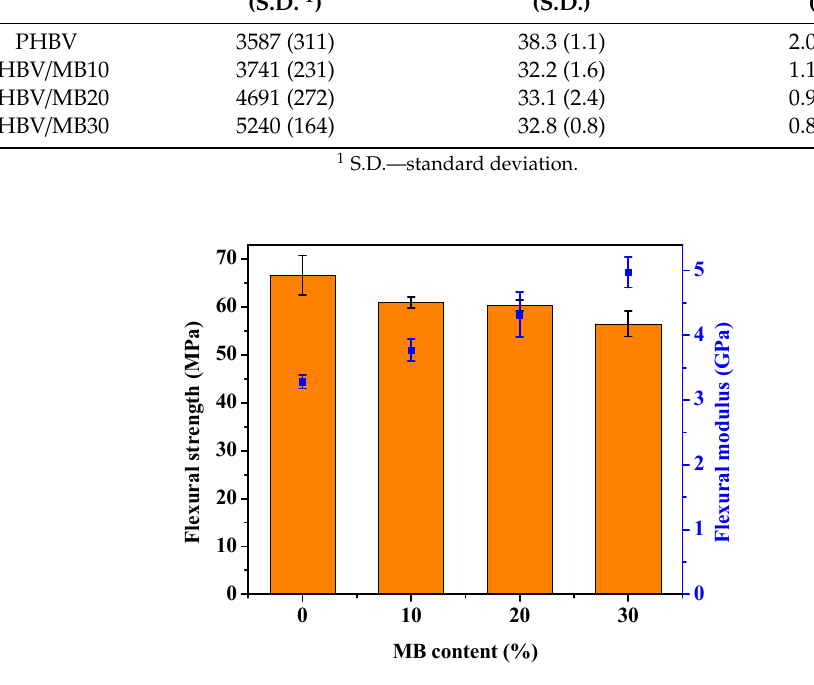
Figure 2. Flexural strength (bars) and modulus (dots) of the PHBV and PHBV/MB composites.